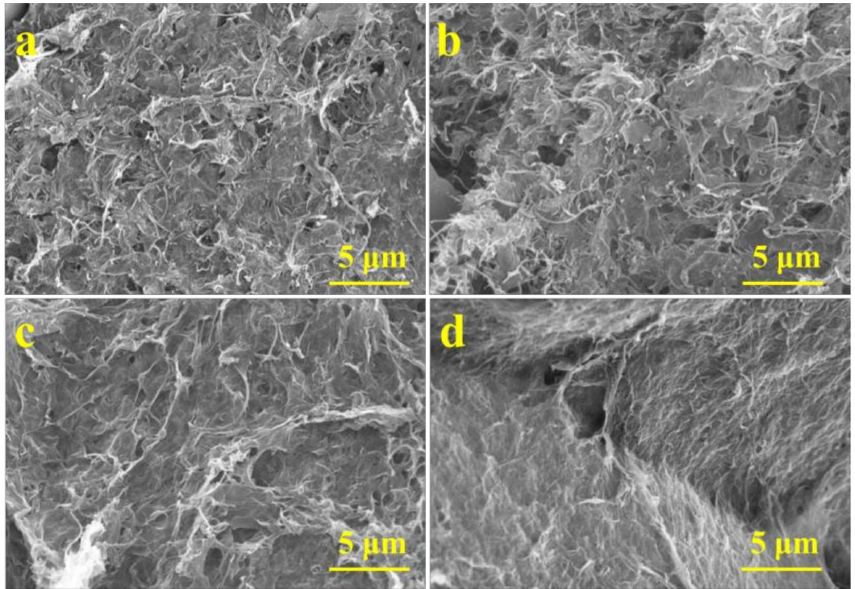
Figure 8. SEM image of aerogels with with different CNTs content; ( a ) GO:CNTs(wt) = 1:2; ( b ) GO:CNTs(wt) = 1:1; ( c ) GO:CNTs(wt) = 2:1; ( d ) GO:CNTs(wt) = 3:1.